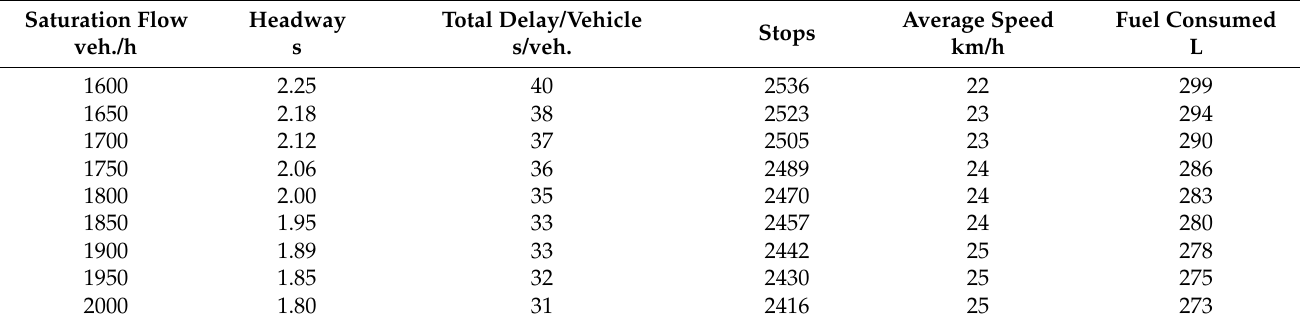
Table 5. Fuel consumption at the intersection depending on the output saturation